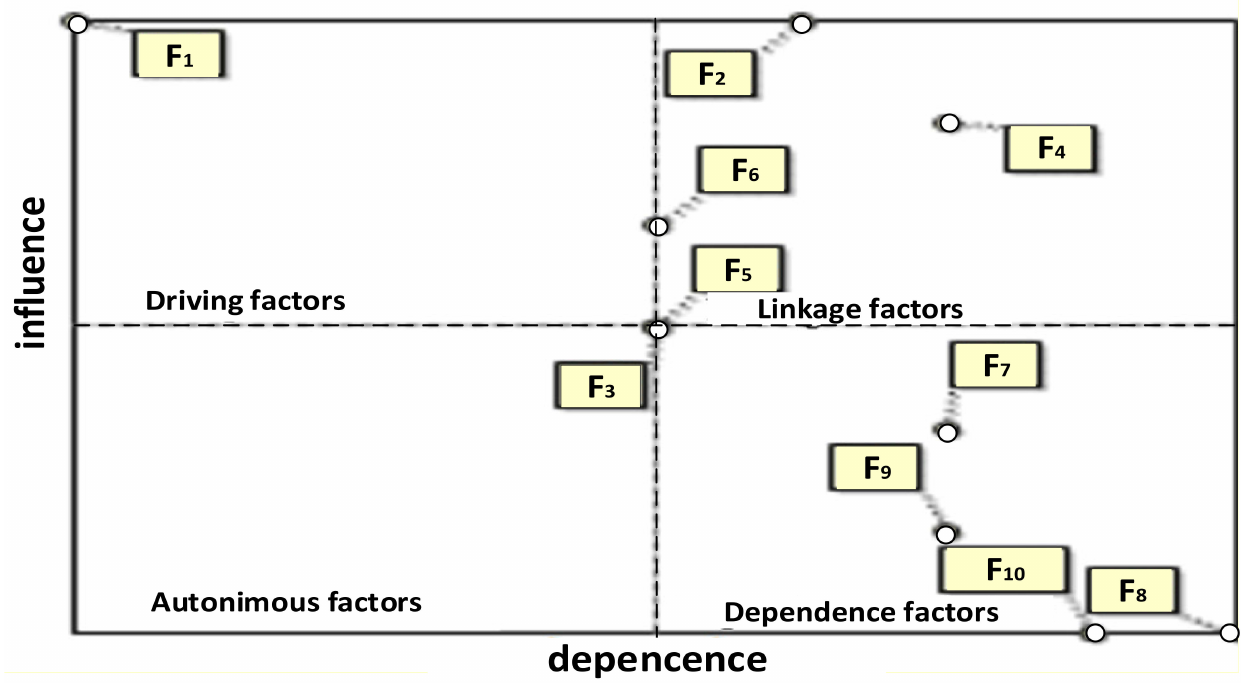
Figure 3. Direct influence map according for the safety culture factors with identified